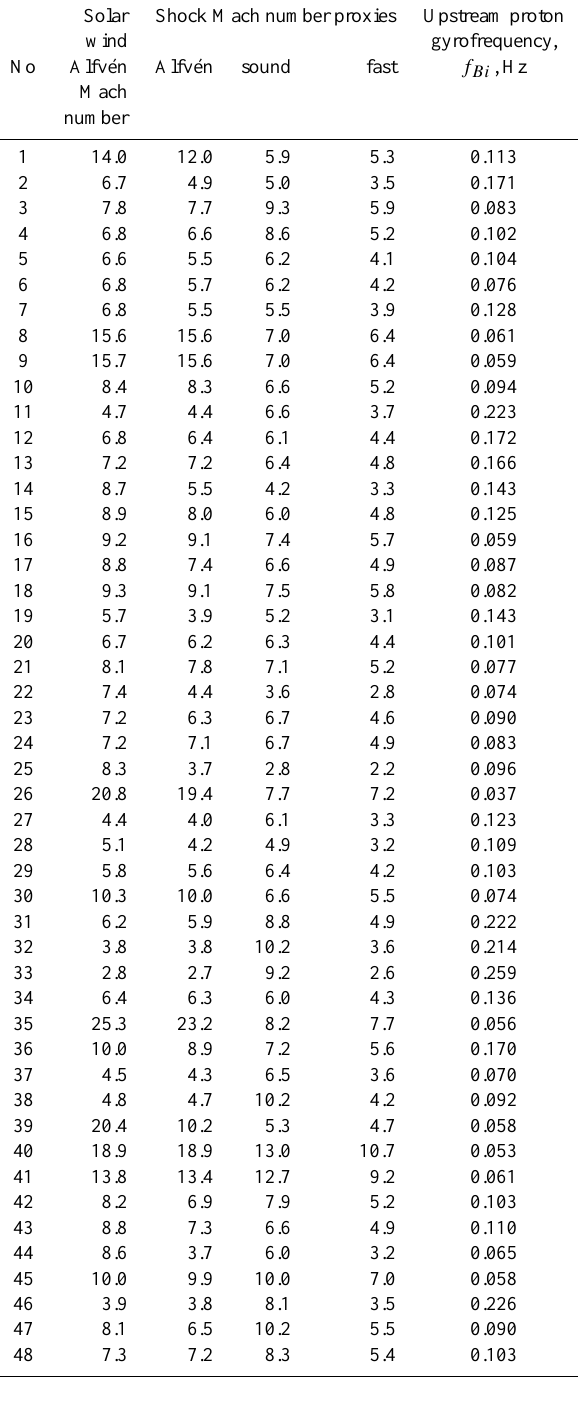
Table 2. Parameters of the shocks related to the events studied. Solar Shock Mach number proxies Upstream